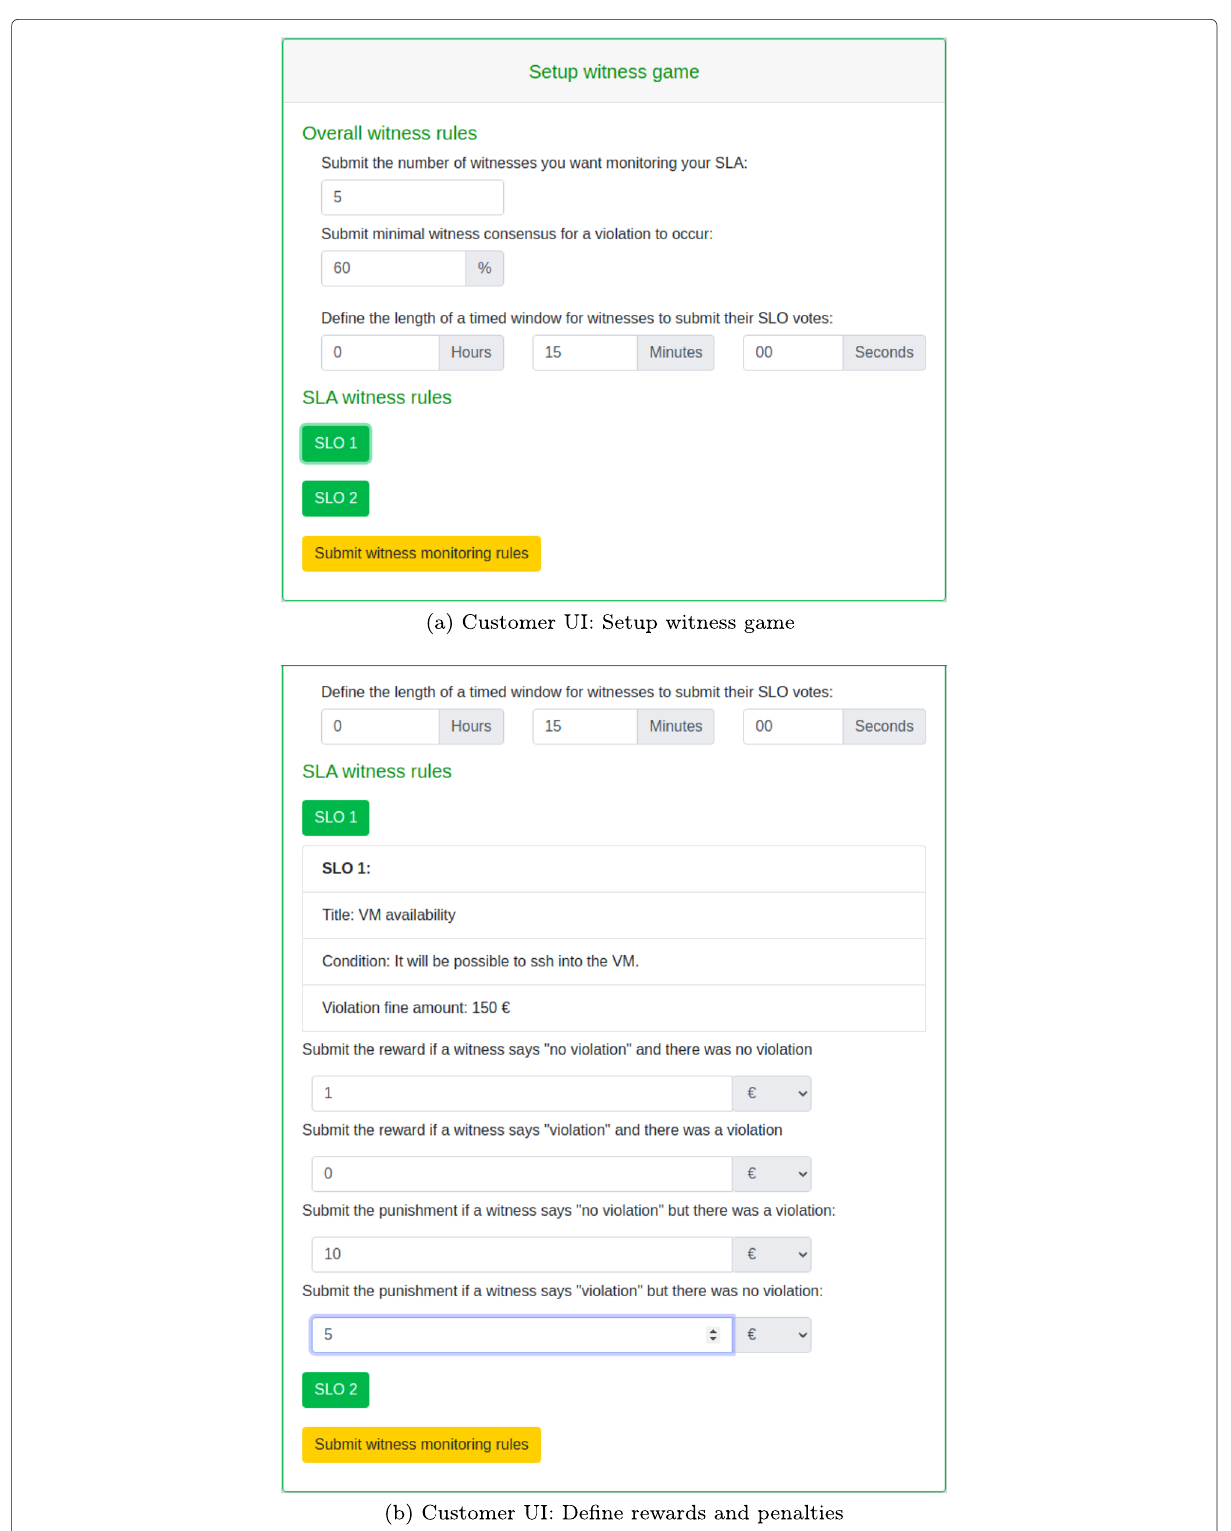
Fig. 10 The auction initiator (i.e., the customer in this auction) sets the monitoring rules for